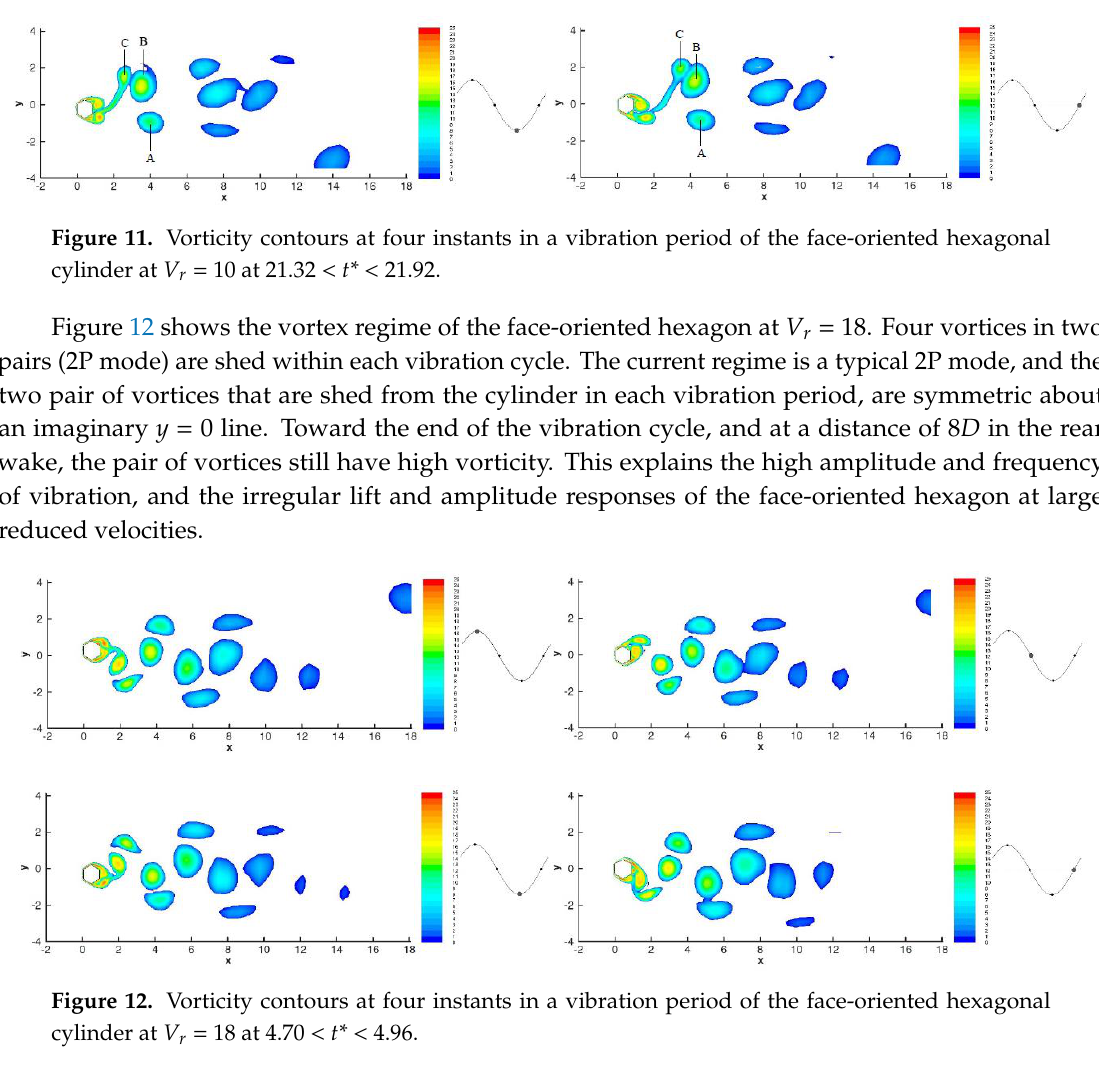
Figure 10. Vorticity contours at four instants in a vibration period of the face-oriented hexagonal cylinder at Vr = 2 at 83.23 < t* < 93.70.